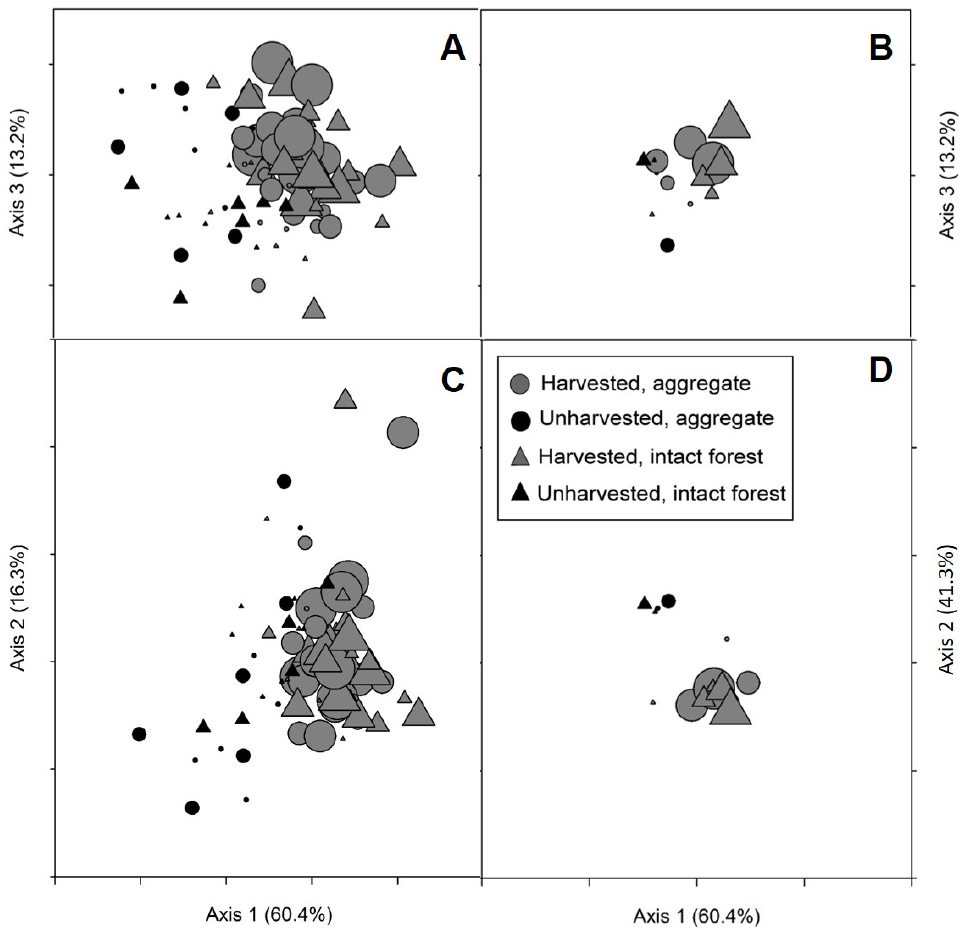
Figure 2. Three ‐ dimensional NMS ordination of plots based on structural conditions. Panels ( A , C ) illustrate all replicate plots while panels ( B , D ) are the centroids for each condition. The shade indicates whether plots were located in unharvested areas under mature overstory (black) or in regenerating harvested areas (grey). Symbol shape indicates either aggregate transects (circles) or intact forest transects (triangles), while greater symbol size corresponds with increasing distance (range 5–45 m) from harvest edge. Correlations between structural components and NMS axes are provided in Table 1. Table A2 contains mixed effects ANOVA results indicating treatment effects on differences in axis scores between observed and reference plots.